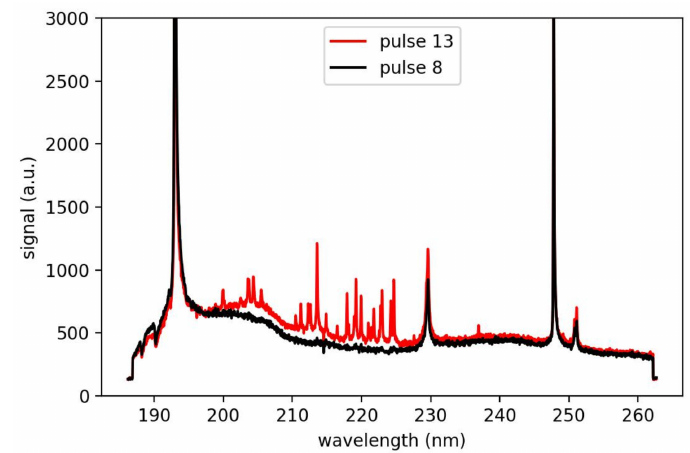
Figure 7. LIBS Spectrum of pulse 8 and 13 of an